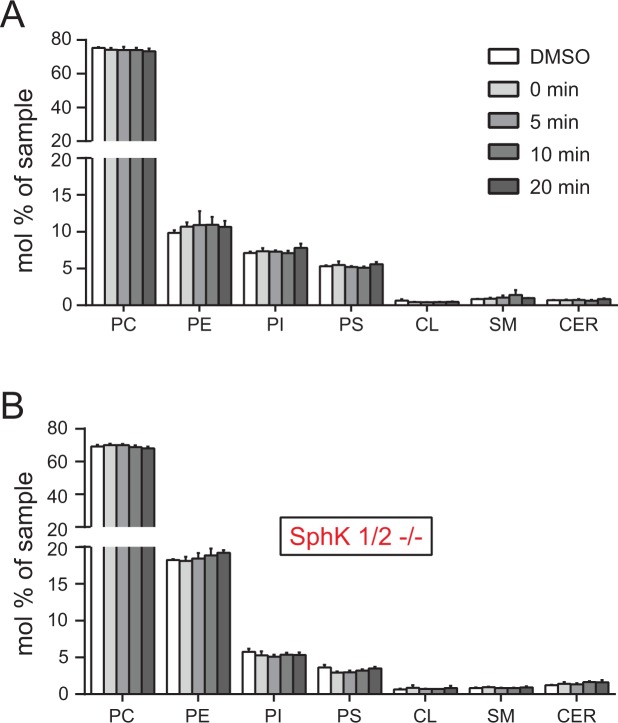
Total lipid analysis of mito-caged probes in Hela cells and SphK dKO cells.No significant differences due to the different conditions were found. Values were normalized with respect to the amount of internal standards and were plotted as percentage of all lipid signals. Data represents the average of three independent experiments. Error bars represent SEM.